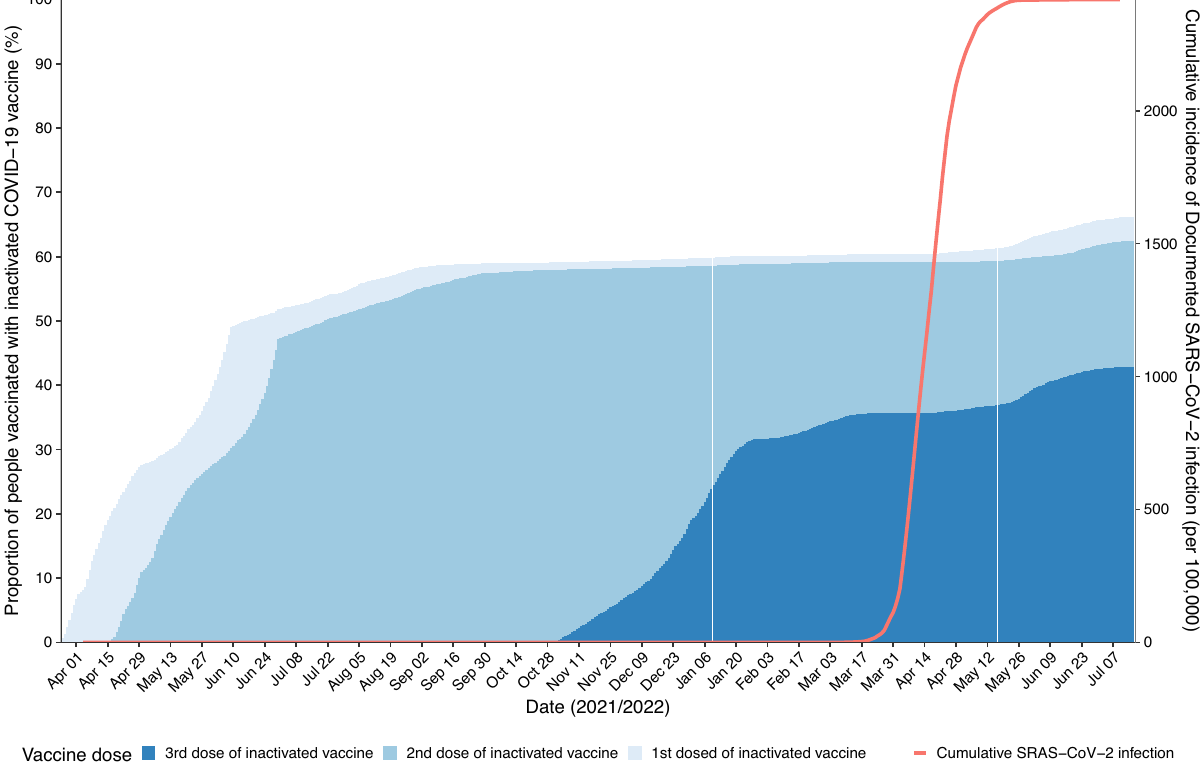
vaccinated with fi rst dose, second dose, and third dose of inactivated Covid-19 vaccine, respectively. Red line shows the cumulative incidence of documented SARS-CoV-2